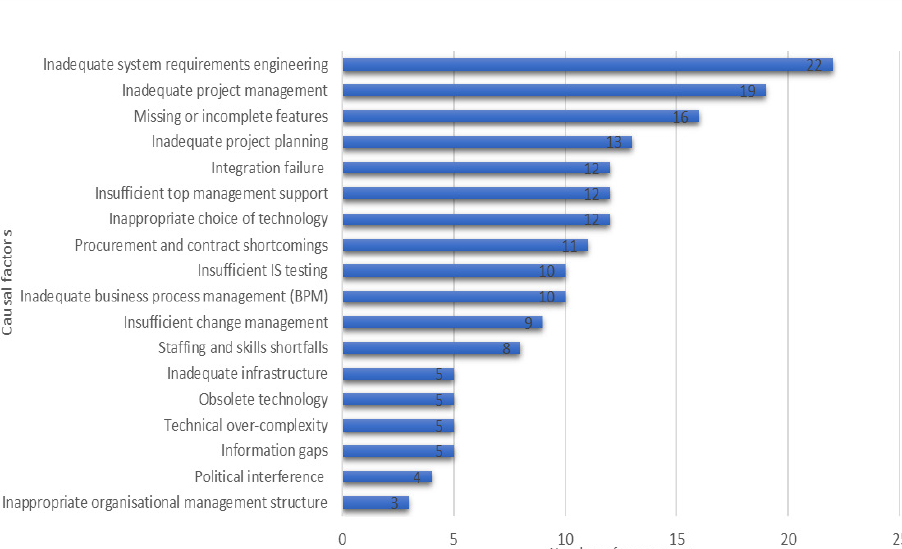
Figure 21: Number of root causes per causal